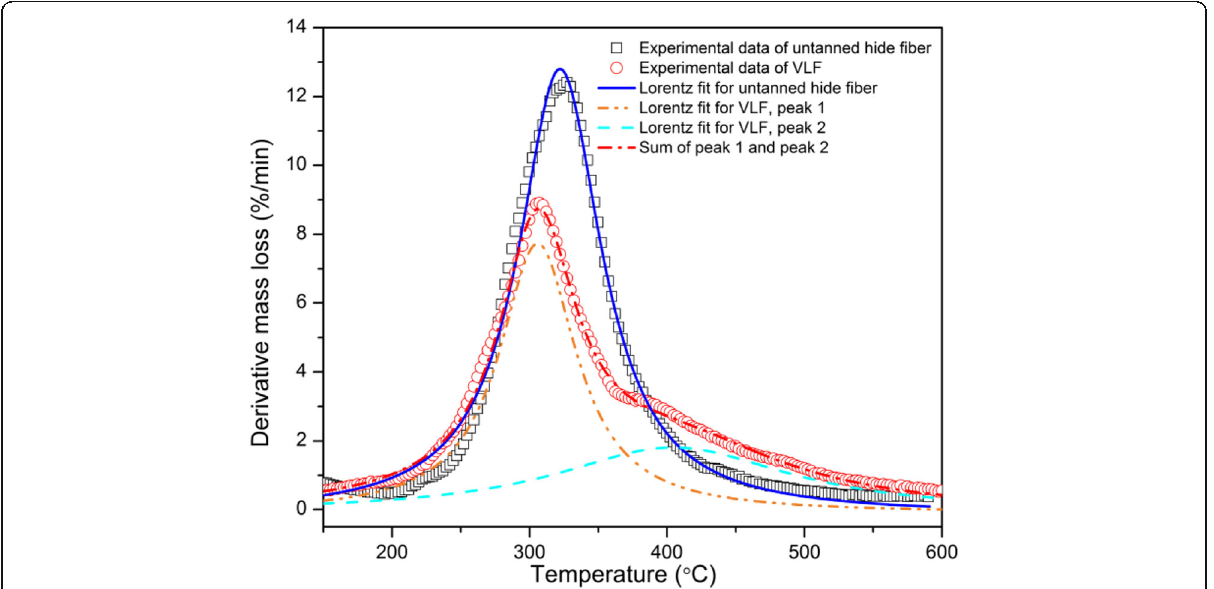
Fig. 8 Deconvolution and Lorentz fitting of DTG curves for VLF and untanned hide fiber at a heating rate of 20 °C min −